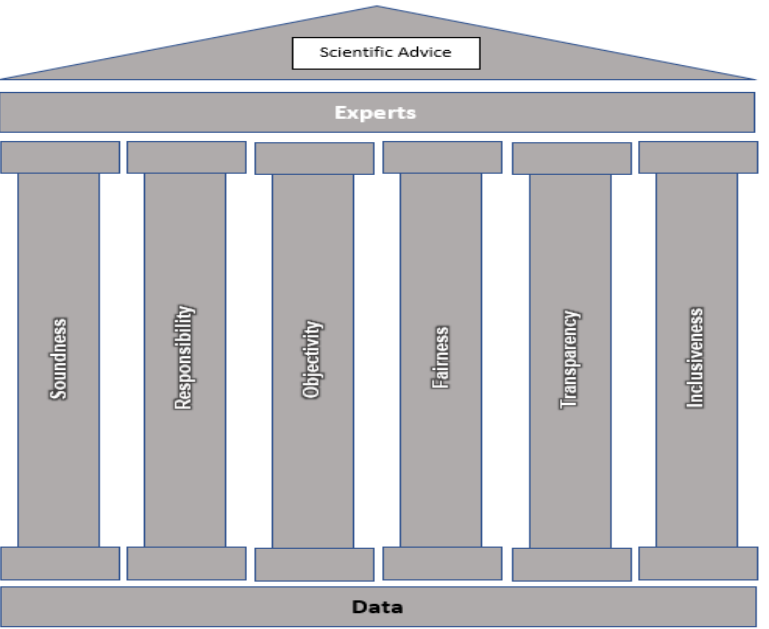
Figure 2. Representation of the core principles underpinning the JEMRA scientific advice frame- work.